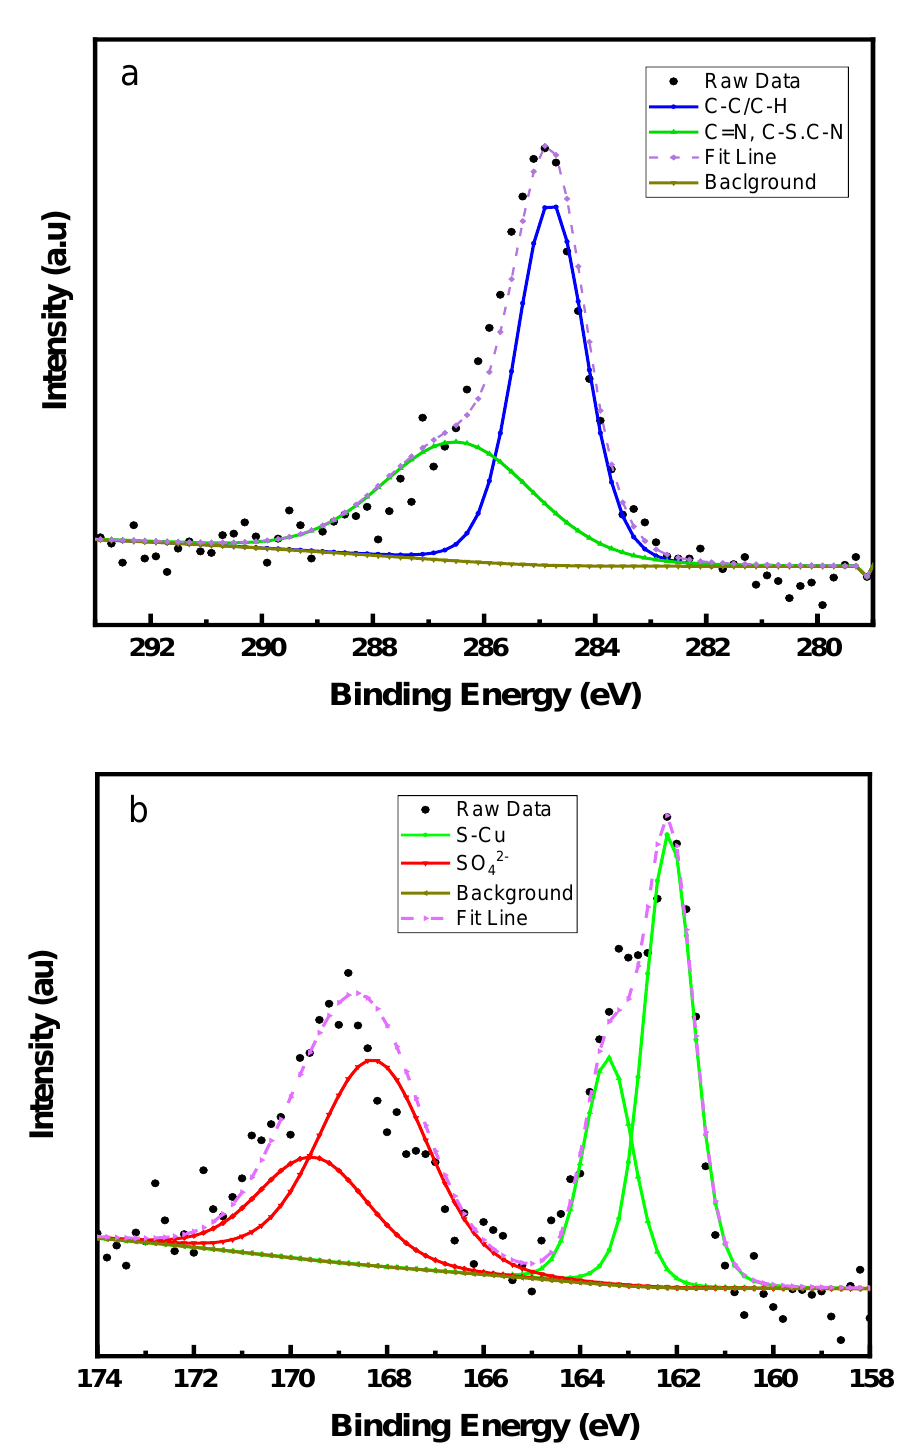
Figure 11. ( a ) C 1s and ( b ) S 2p spectra of P2T treated brass sample. This shows that the inhibitor molecules attach through a S-Cu bond to give a stable inhibitor layer coverage on the brass surface. The N and O XPS spectra are shown in Figure 12a,b. The N 1s spectrum consists of a single peak at binding energy of 400.3 eV and can be assigned to the protonated nitrogen atom in the pyridine ring [51,52]. There is no peak visible for N-Cu bond formation around 399 eV which confirms that all the nitrogen atoms are in the protonated form, since the pH of the corrosive medium is less than 1 [53,54]. The O 1s peak (Figure 12b) has only one component at a binding energy around 530.8 eV which can be attributed to the formation of Cu 2 O [55]. There is no peak around 529.7 eV for the formation of CuO. This indicates that adsorption of pyridine thiol blocks